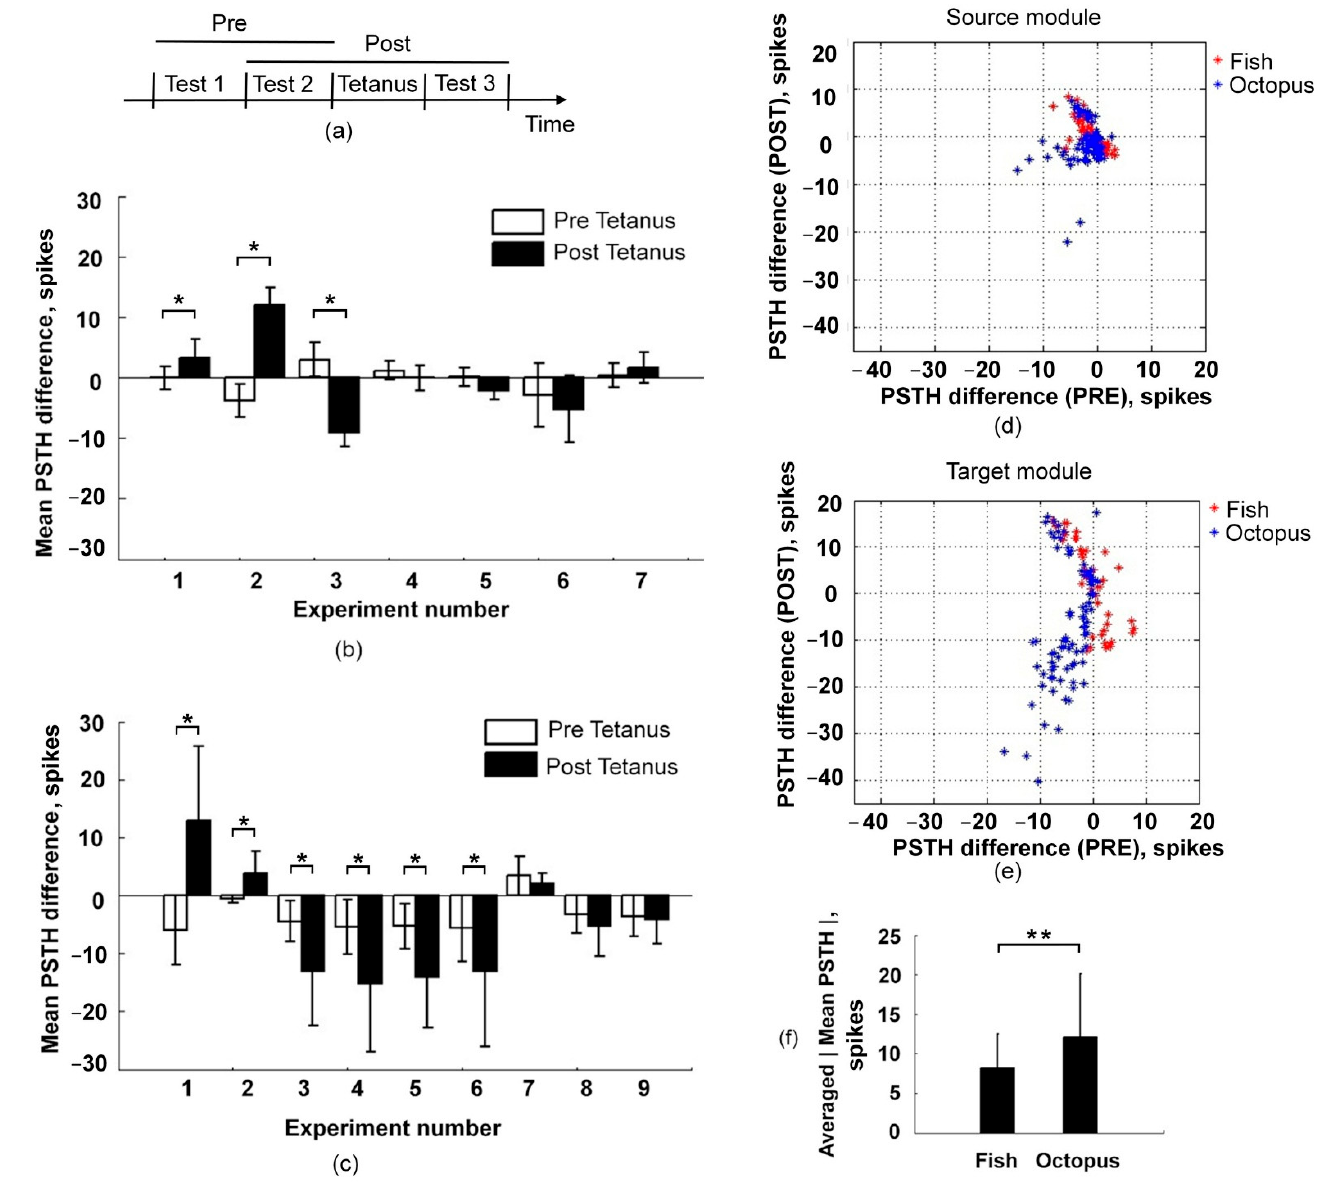
Figure 4. Tetanus-induced changes in evoked responses. ( a ) Schematic illustration of the experimental protocol. ( b , c ) Mean of PSTHs difference of the responses in pre- (white bar) compared with the mean difference in post-tetanus (black bar) (see Methods) in Fish ( n = 7 experiments, 3 cultures) ( b ) and Octopus chips ( n = 9 experiments, 4 cultures) ( c ). Mann–Whitney Rank Sum Test, p < 0.05 (*). ( d , e ) Scatter plot of the PSTH difference in each electrode for pre- and post-tetanus of the Fish (red) and the Octopus (blue) chips for the Source ( d ) and the Target module ( e ). Only experiments with a significant effect of tetanization are shown. ( f ) The averaged absolute values of mean PSTH after tetanic stimulation (see Methods) of cultures in Fish ( n = 3 experiments) and Octopus chips ( n = 6 experiments). Mann–Whitney Rank Sum Test, p < 0.01 (**).